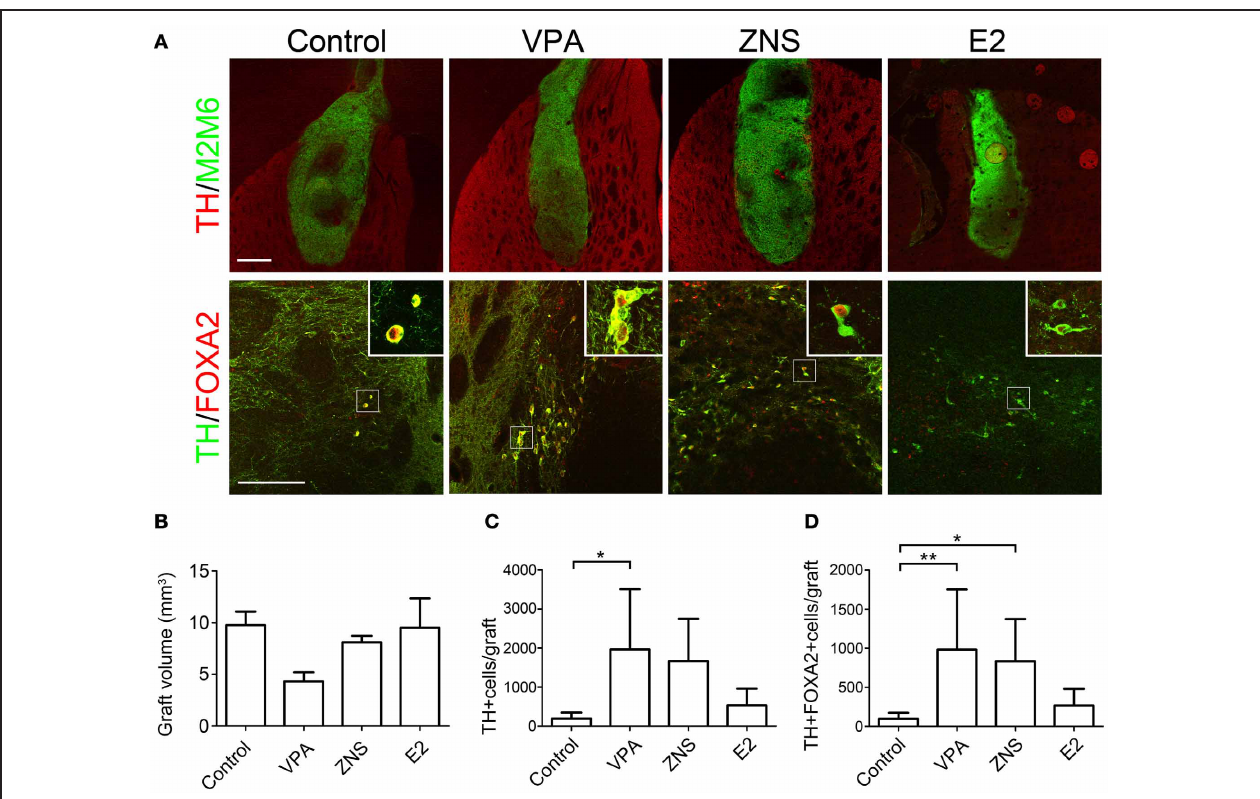
50 μ m (lower). A comparison between each group for (B) average graft volume, (C) the number of TH + cells per graft, and (D) the number of TH + FOXA2 + cells (midbrain DA neurons) per graft. The data are presented as the mean ± SD. ( ∗ P < 0 . 05, ∗∗ P < 0 . 01; n = 8 control, n = 6 VPA, ZNS,